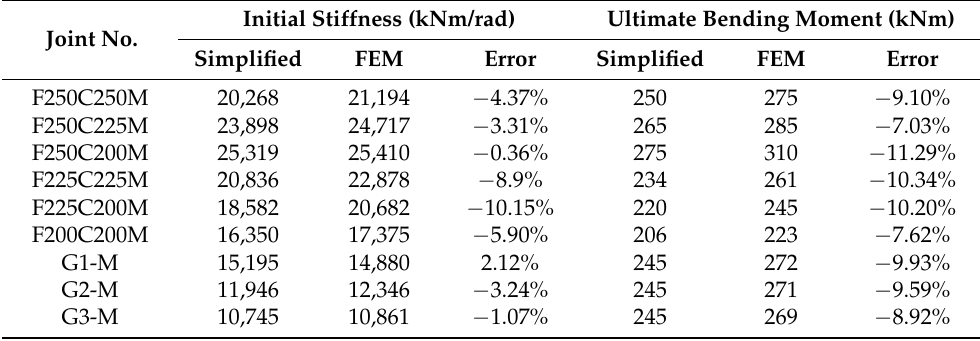
Table 4. Comparison between the simplified model and the finite element model of novel modu- lar